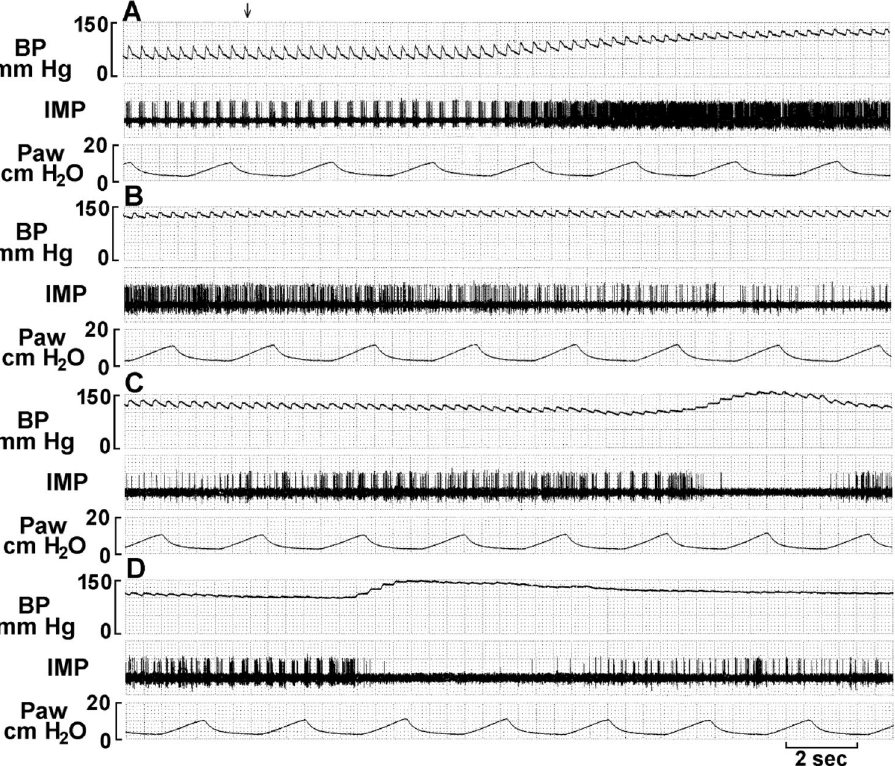
Figure 9. Another baroreceptor unit in response to phenylephrine injection (indicated by the arrow in A). A and B, and C and D are in continuance with a 30 s elapse between B and C. Please note that after inactivated, the unit became active as blood pressure was lowered by withdrawal of blood from the femoral artery (about 20 ml) at the beginning of C. The unit was inactivated again by increasing the blood pressure by injection of the blood into the artery. Such activation and inactivation can be repeated.